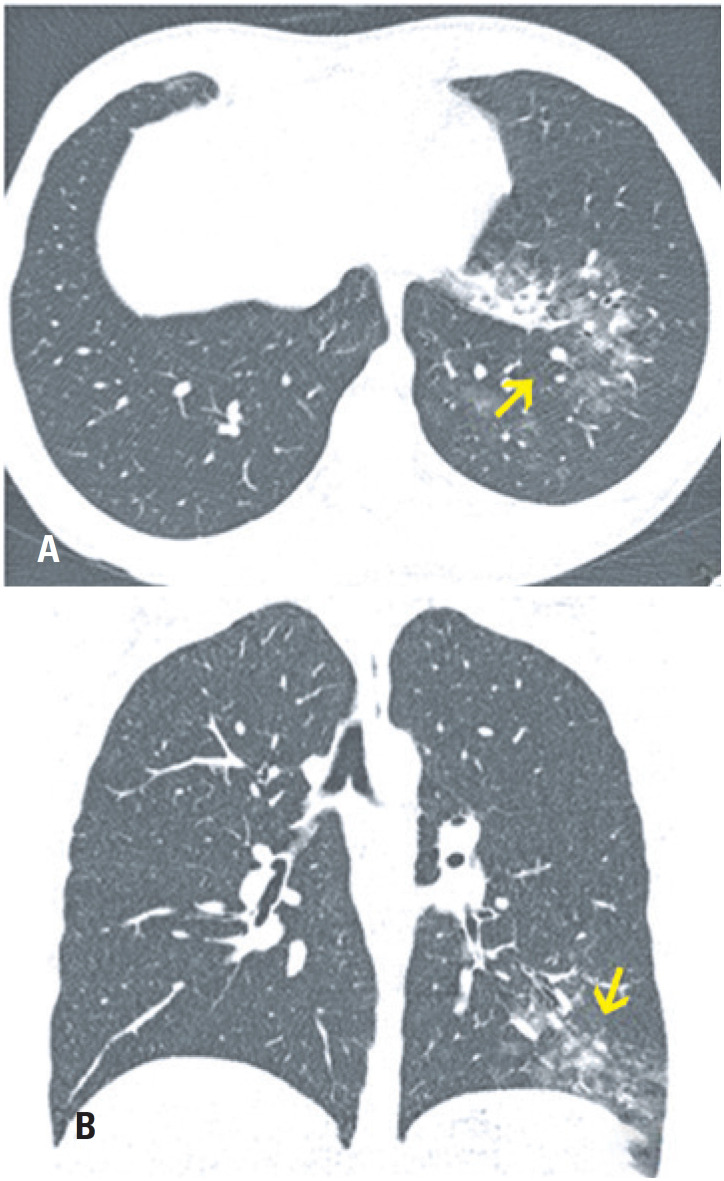
Homem, 28 anos, com queixa de tosse, cefaleia e febre há 4 dias. Tomografia computadorizada (A) Com corte axial (B) Coronal: espessamento de paredes brônquicas, associado a opacidades em vidro fosco broncocêntricas confluentes nos segmentos basais do lobo pulmonar inferior esquerdo. Tais achados são compatíveis com processo infeccioso pulmonar broncopneumônico. Confirmado por exame de proteína C-reativa respiratório:
Mycoplasma pneumoniae